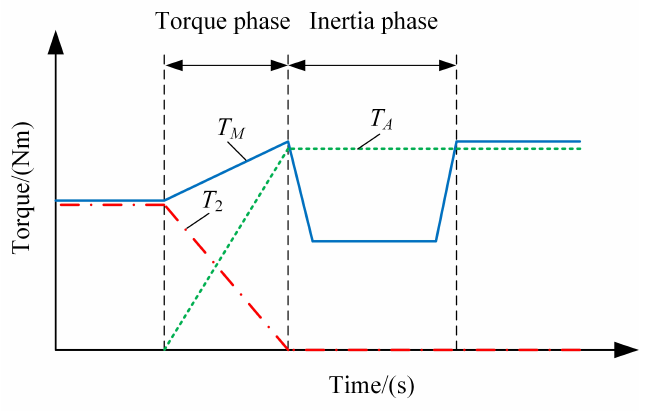
Figure 3. Schematic diagram from second gear to third gear.